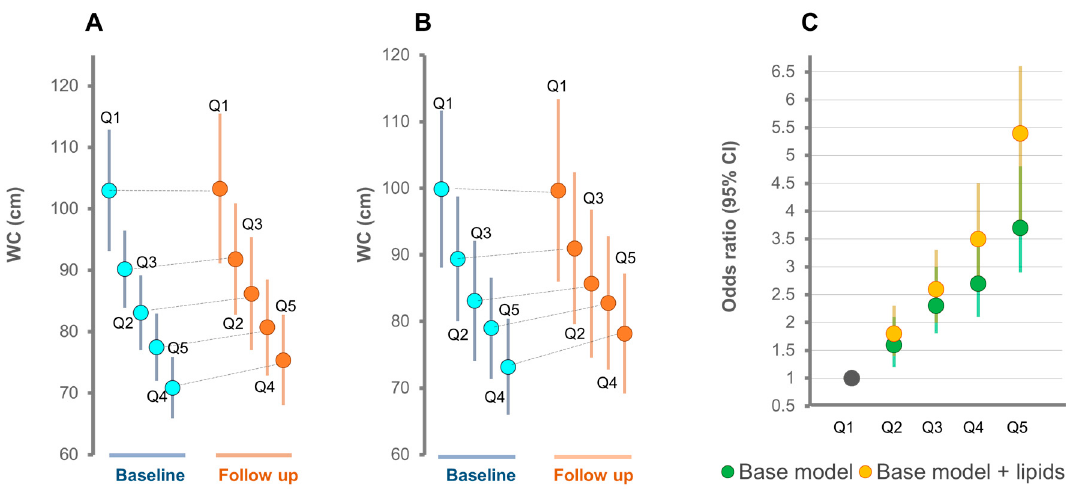
Figure 6. Risk of gaining WC across quintiles of metabolic scores in women. ( A ) Baseline and follow-up WC measures (mean ± SD) across quintiles of the metabolic score derived from the base model, Model 1, and ( B ) from the base model plus lipids, Model 2. ( C ) The relative risk of a >5% WC change across quintiles of the metabolic score. Base model (age, sex, WC, total cholesterol, HDL-C, triglycerides, smoking, exercise time, TV viewing time, energy intake); lipids, all the lipid species associated with change in WC.